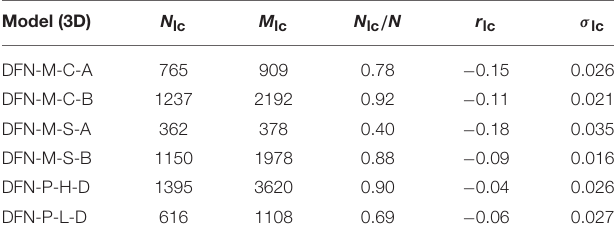
TABLE 3 | Average values for number of nodes N lc , links M lc , average ratio of nodes in the largest component and the entire graph N lc / N , as well as assortativity coefficient r lc with its standard deviation σ lc , for the largest component for 50 samples of each of the different limits of the two DFN models in three dimensions.